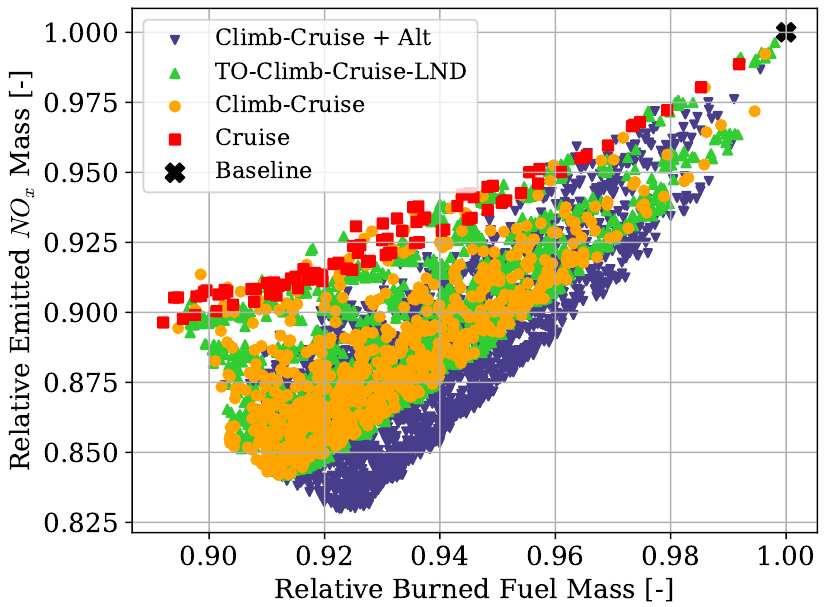
Figure A4. Objective space of Linear strategies with different hybridised mission